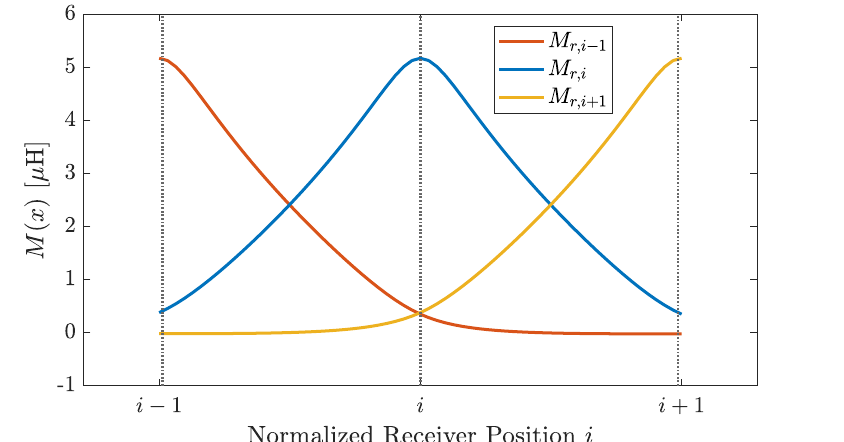
Figure 7. Equivalent circuit of a resonator array with a receiver.